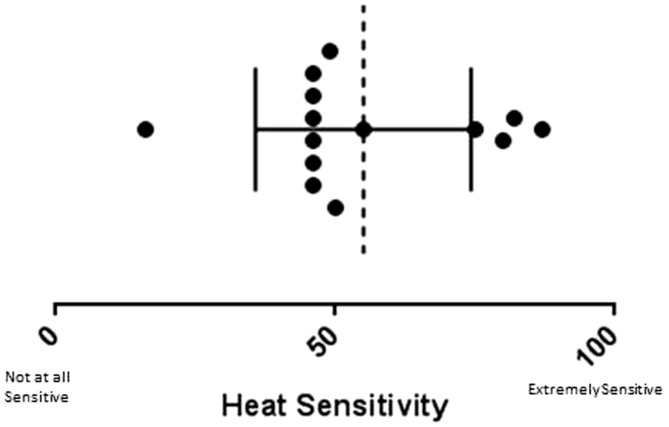
Ratings of heat sensitivity rating on heat sensitivity visual analog scale (VAS; score out of 100). Each circle is a participant. Dashed line is the mean and horizontal error bar is the standard deviation (SD).